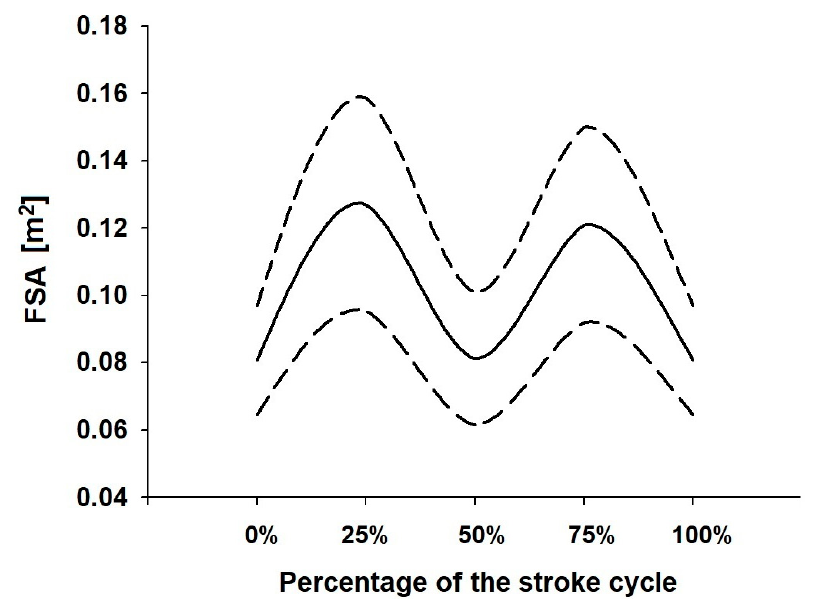
Figure 1. Frontal surface variation (FSA) during an entire stroke cycle. Solid line represents the average, and dashed lines represent the 95% confidence intervals.